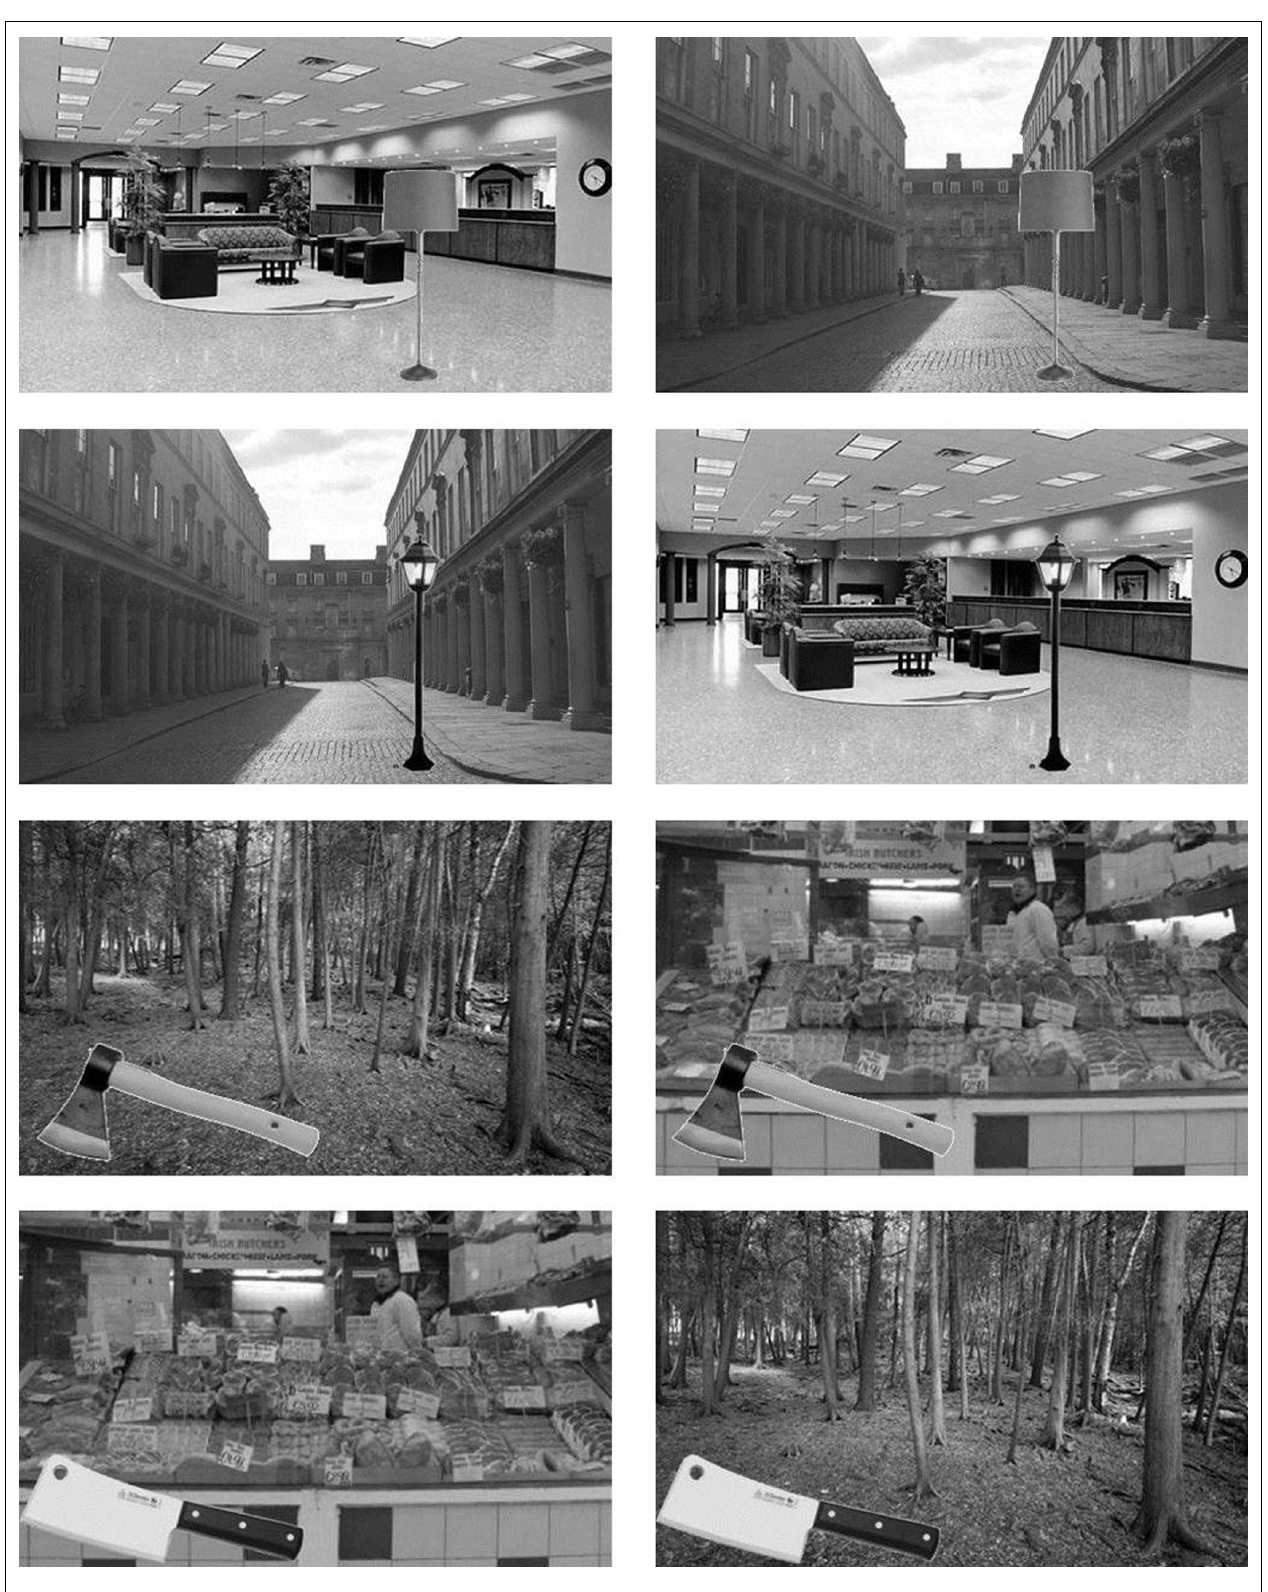
FIGURE 4 | Example stimuli used in Experiments 2, 3a, and